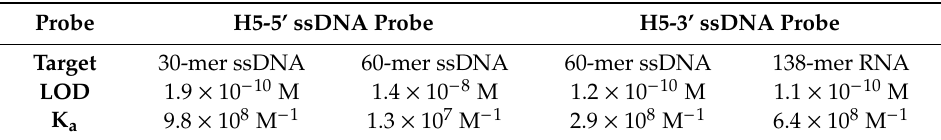
Table 3. LOD and K a comparison obtained by FOPPR biosensor with di ff erent combinations of ssDNA probe and target as shown in Figure